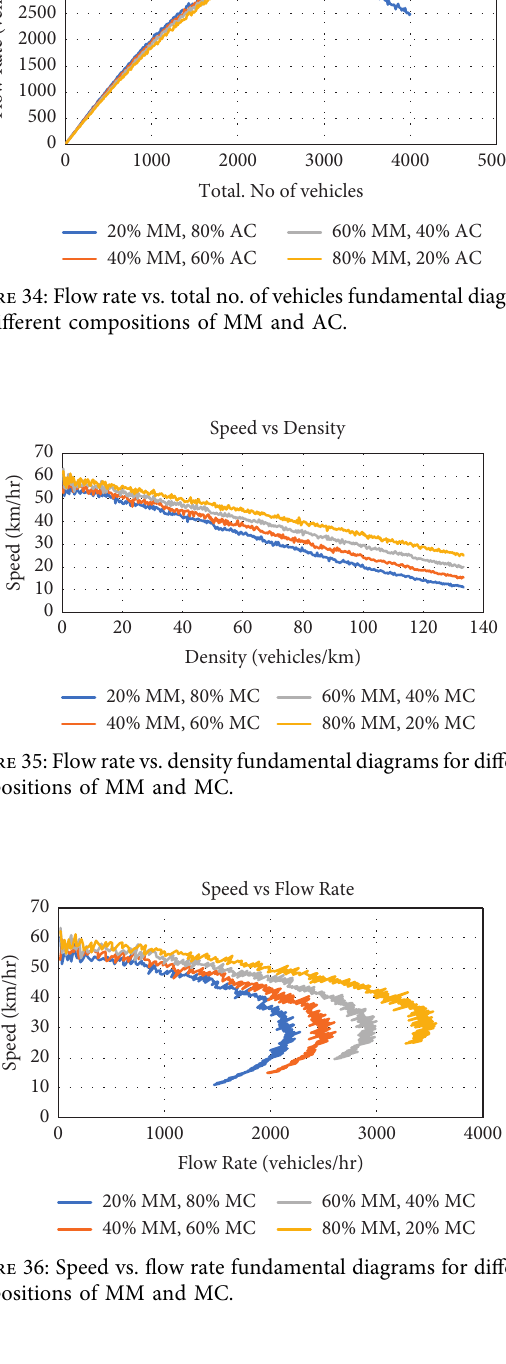
Figure 33: Flow rate vs. density fundamental diagrams for different compositions of MM and AC.